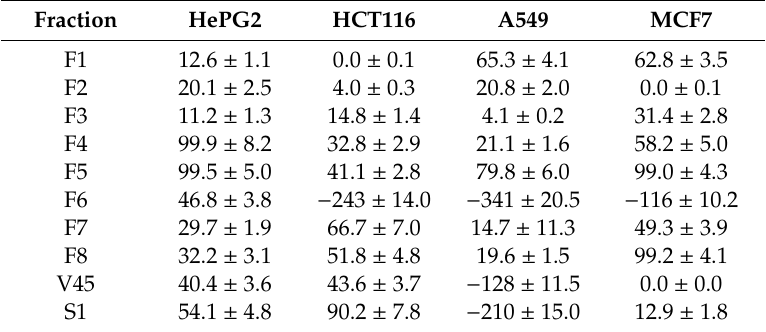
Table 3. Lethality percentage for the algal extract and column fractions at 100 ppm, as tested on four cancer cell